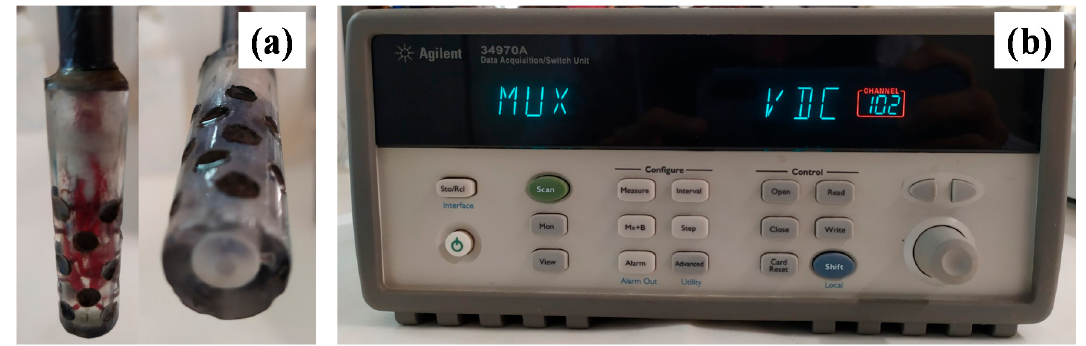
Figure 2. ( a ) E-tongue sensor arrays (cylindrical acrylic body with 20 circular lipid sensor membranes). ( b )